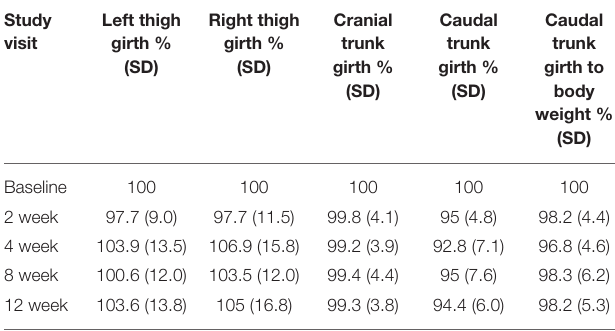
TABLE 4 | Mean thigh and body circumference measurements as a percentage of baseline values. Study